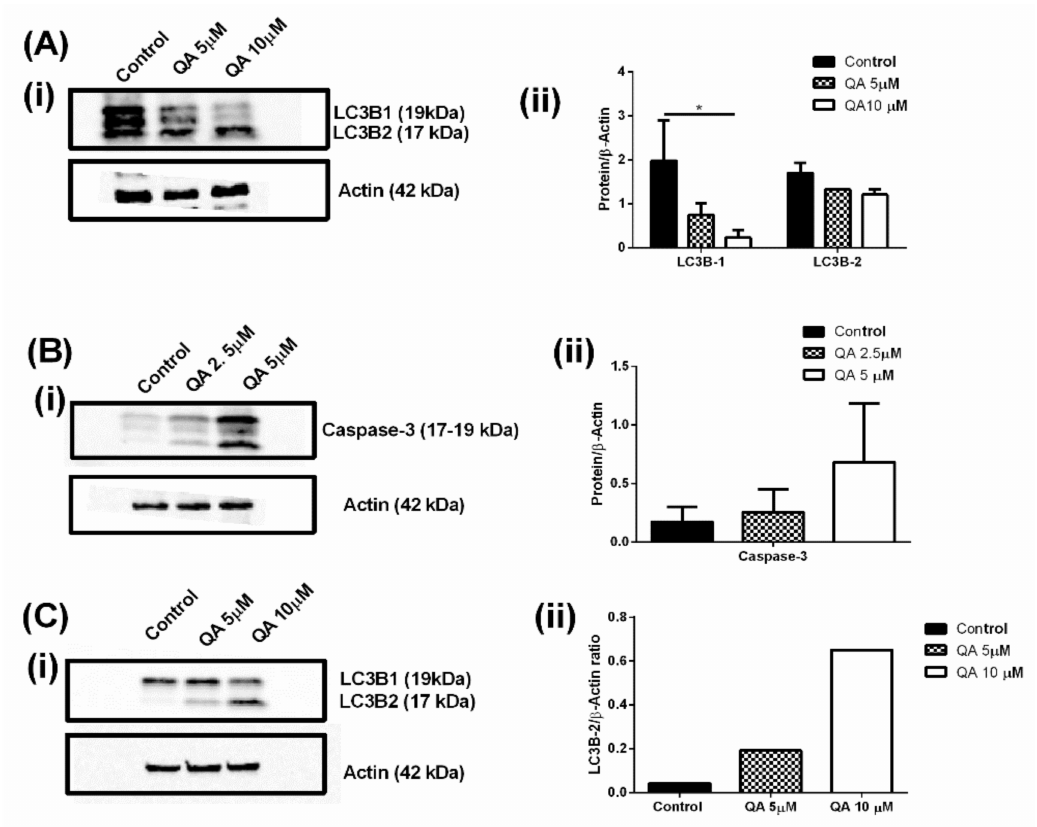
Figure 8. ( A )-i Western blots representing the expression level of two subtypes (1 and 2) of LC3B protein post QA treatment (5- and 10 µ M, 24 h) in MSTO-211H cells. It can be clearly seen that LC3B-1 is downregulated and LC3B-2 is upregulated in MSTO-211H cells, indicating successful inhibition of autophagy. ( A )-ii Plot represents band intensity ratio for protein and B-actin for LC3B protein subtypes in MSTO-211H cells. A significant di ff erence can be seen for LC3B-1 downregulation for QA treated cells as compared to control cells. ( B )-i Western blot representing expression level of caspase-3, which is overexpressed in apoptotic events. It can be clearly seen that QA treatment (2.5- and 5 µ M, 72 h) induces levels of caspase-3, indicating successful apoptosis. ( B )-ii Plot represents band intensity ratio for protein and B-actin for caspase-3 in MSTO-211H cells. An upregulation of Caspase-3 marker can be seen as QA concentration is increased, indicating induction of apoptosis. ( C )-i Blots represent LC3B expression levels in H2452 cells for control cells and QA treated cells. A clear induction in LC3B-2 levels are observed whereas LC3B-1 levels are seen to be downregulated. ( C )-ii Plot represents band intensity ratio for protein and B-actin for LC3B-2 in MSTO-211H cells. Data represents mean ± SD ( n = 3), * p < 0.05, compared between treatment and control groups, as